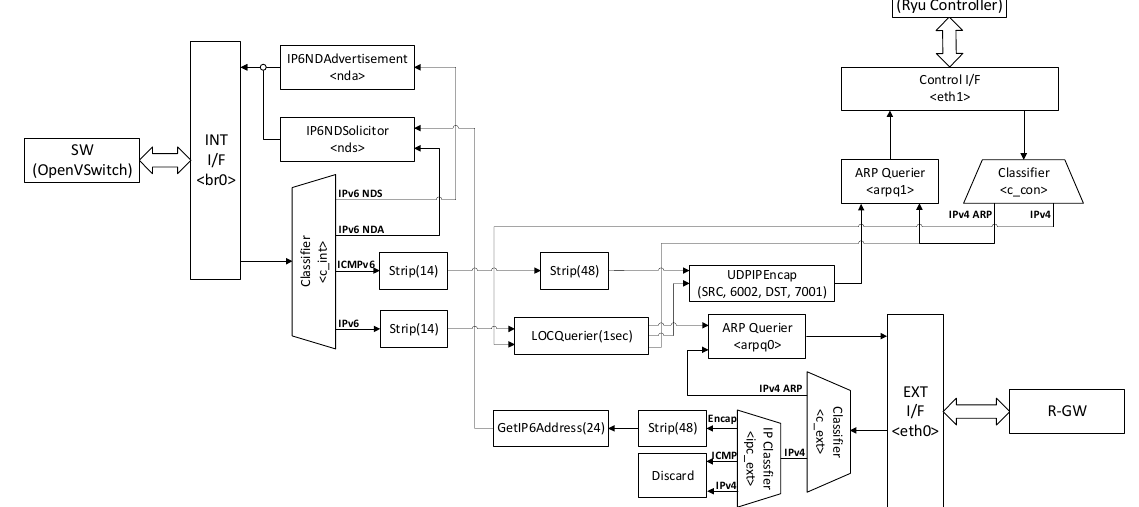
Figure 17. Processing a packet at the R ‐ GW using Click Modular Router.